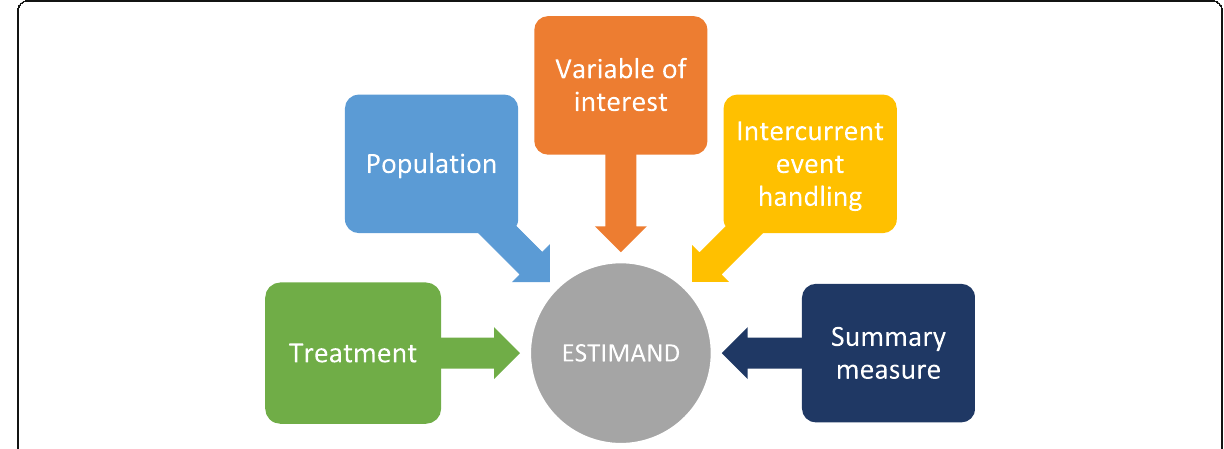
Fig. 1 The five attributes of an estimand according to the ICH E9 (R1) addendum